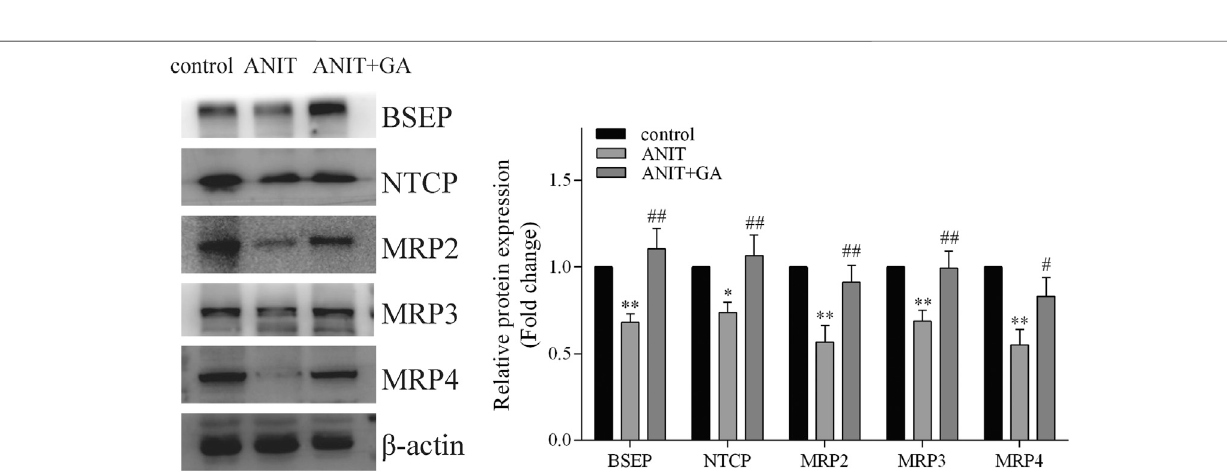
Frontiers in Pharmacology |